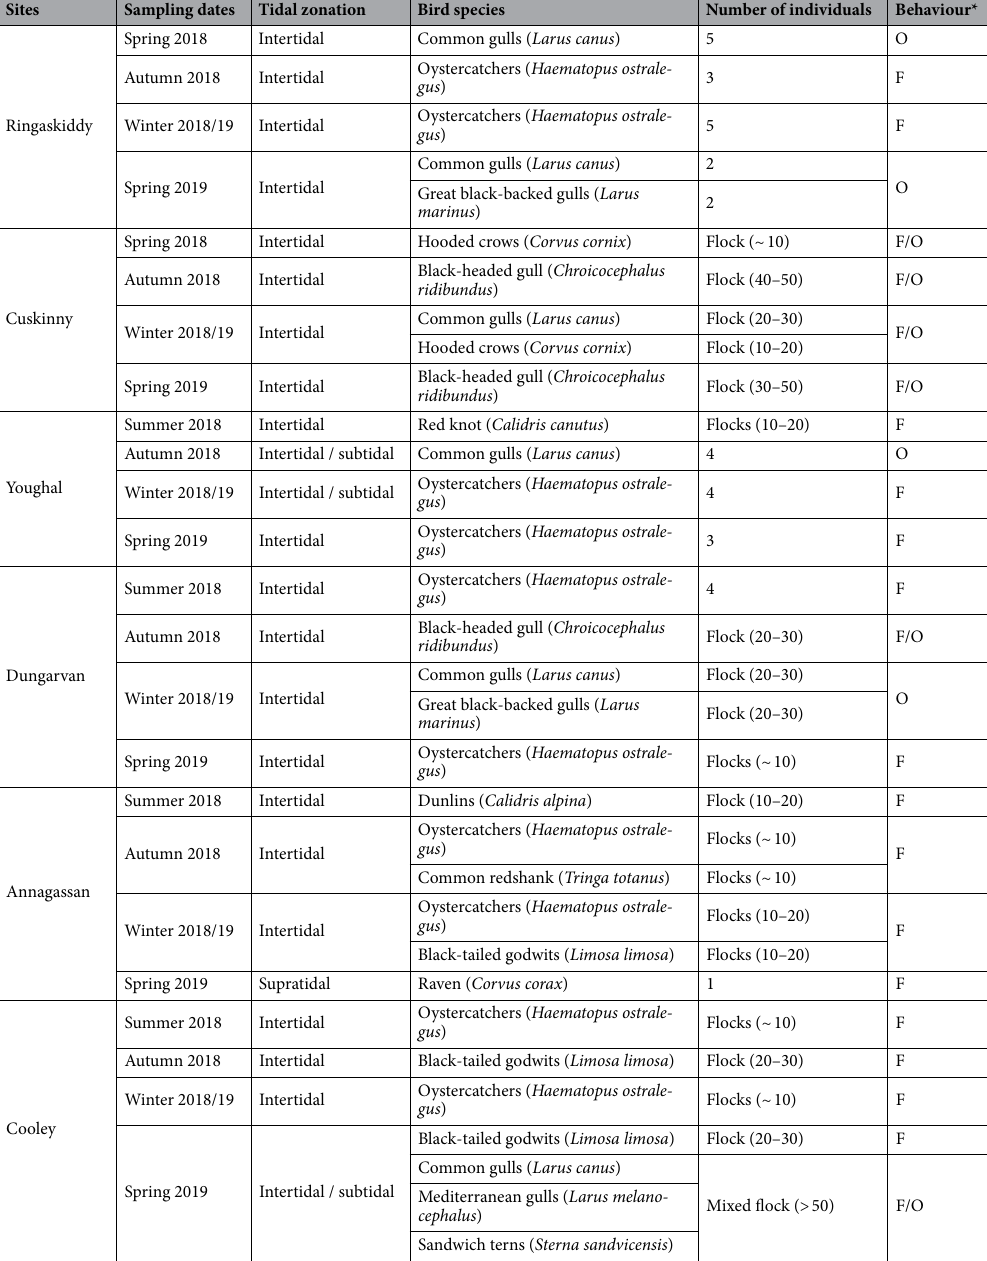
Table 1. The most abundant shorebird species, number, location and behaviour observed at each sample site by season, compiling the main flocks observed in the field. (*) Following the descriptions in Lewis and Tierney 58 , shorebird behaviour was classified in two categories: (F) foraging/feeding: the active or passive search of food and feeding; and (O) other: all other behaviours that do not assign to foraging, including roosting, standing, preening, loafing, swimming and